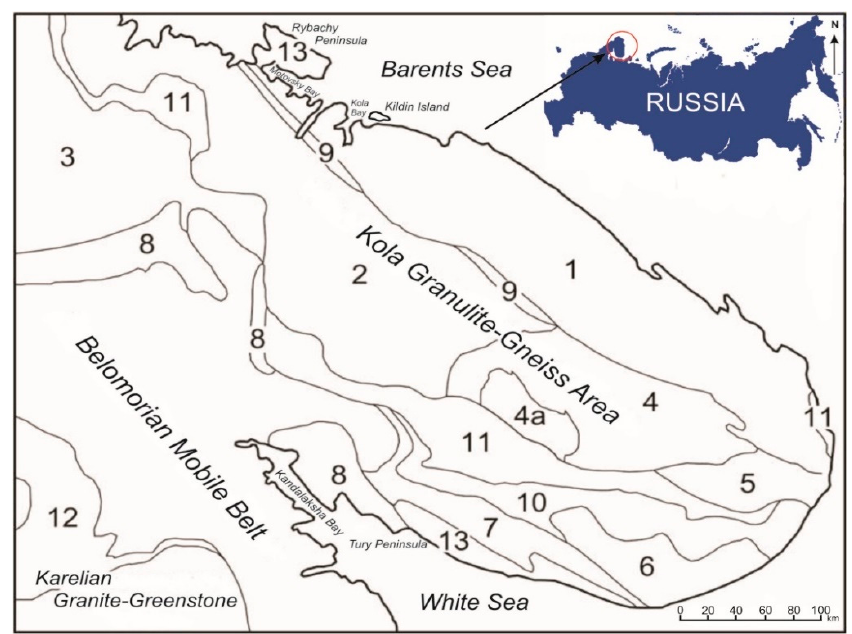
Figure 1. Zoning of the early Precambrian geostructural elements of the Earth’s crust in the northeastern Baltic Shield (Modified from [10]). Crustal domains: 1—Murmansk, Greenstone and granulite belts (8–10—Archaean; 11, 12—Neoproterozoic):